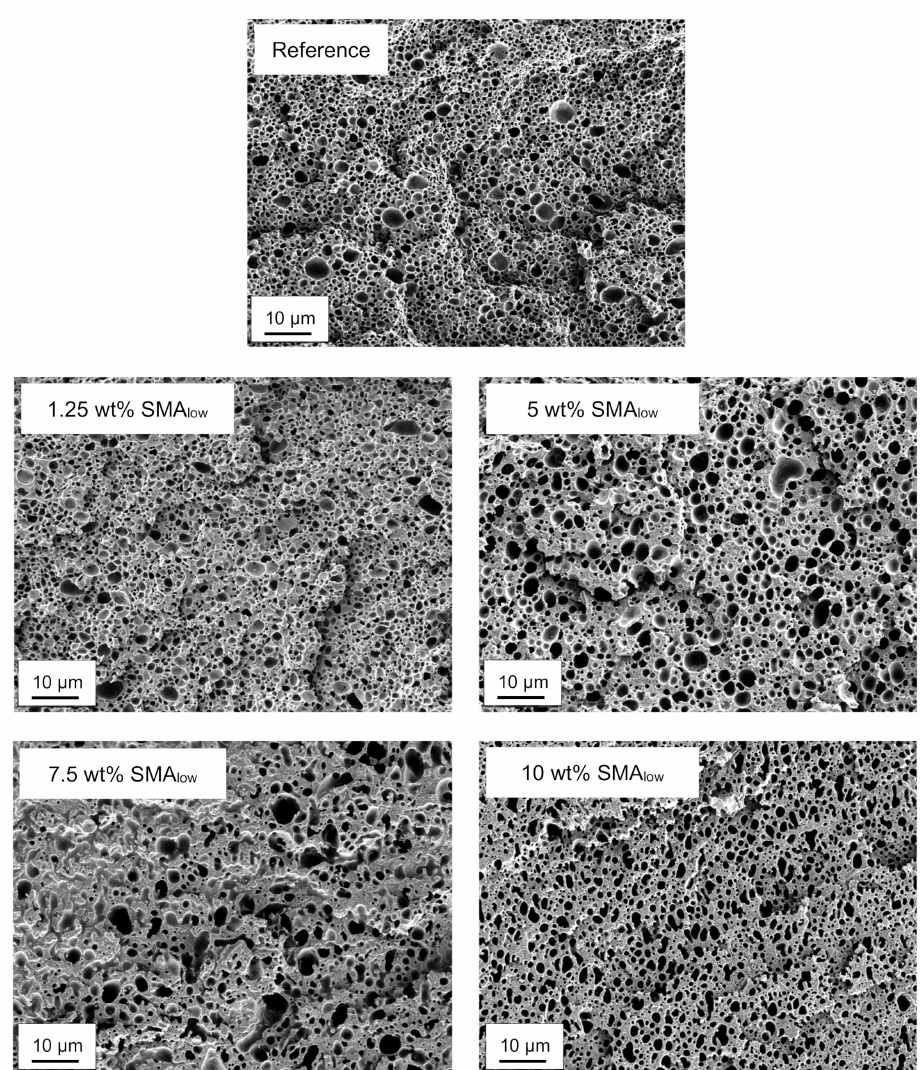
Figure 3. SEM micrographs of selectively etched PA66 / PPE / SMA low ternary